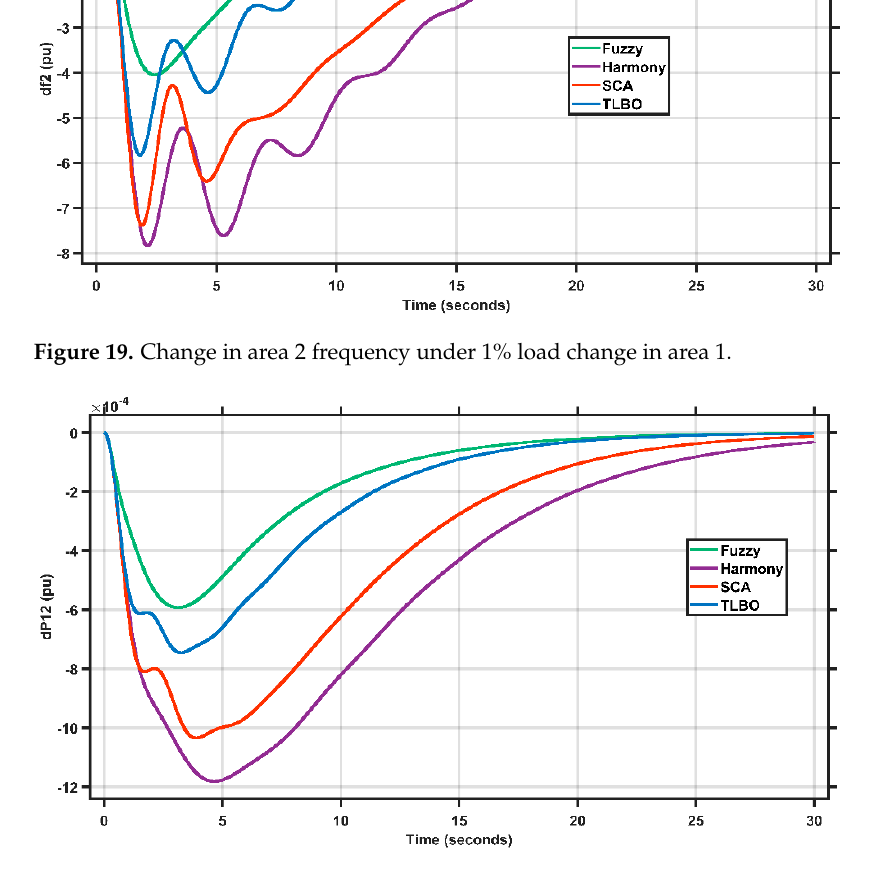
Figure 20. Change in power tie under 1% load change in area 1.